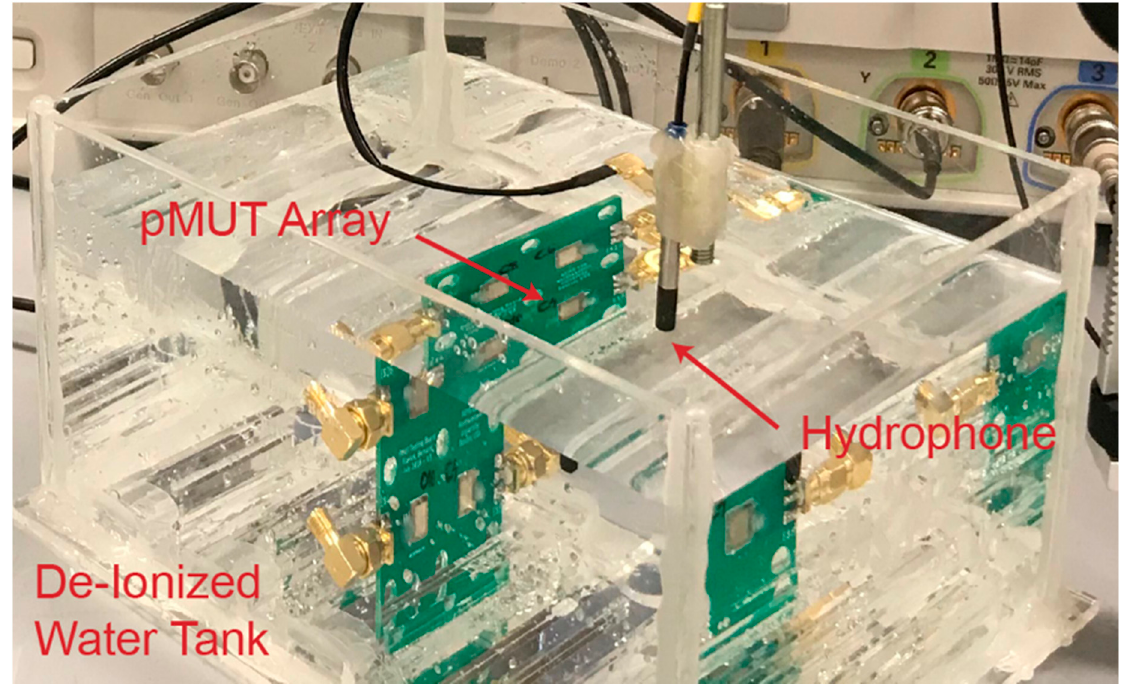
Figure 13. De-Ionized (DI) water tank for ultrasonic experiment measurements. The transmission is done between a pMUT array and an ultrasonic hydrophone (Teledyne TC4038) for reference. Given the small dimensions of the tank, there will be some interference due to the reflections at the interface, creating a multipath. Absorptions layers can be added to the wall to reduce the multipath phenomena.